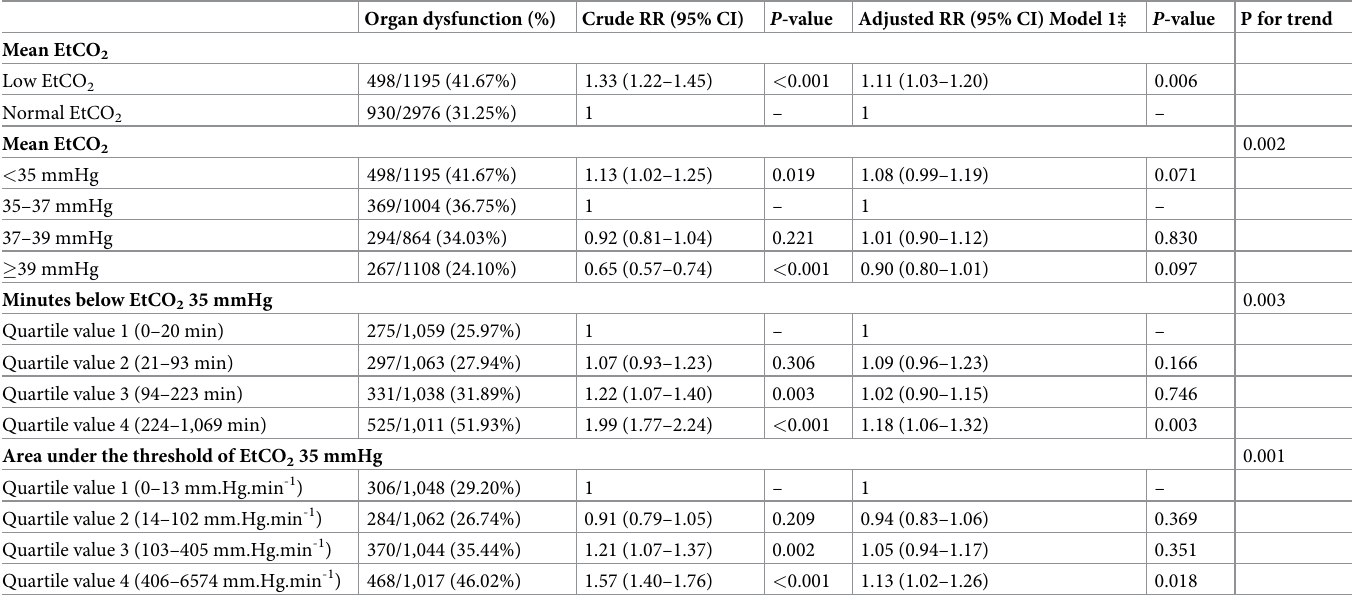
Table 2. Multivariable analysis of the relationship between EtCO 2 and organ dysfunction.